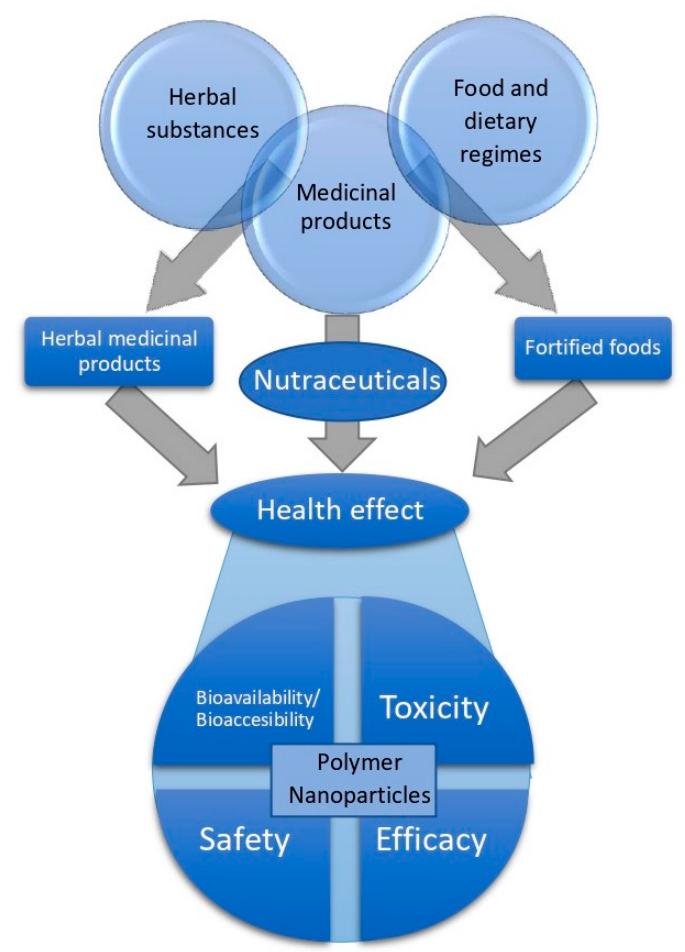
Figure 6. Use of polymeric nanoparticles for nutraceuticals and different bioactive compounds for greater health and medical benefits.